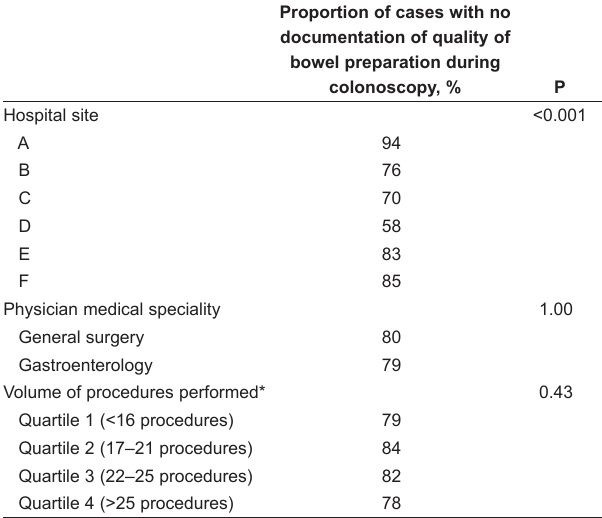
TABle 1 Documentation of quality of bowel preparation